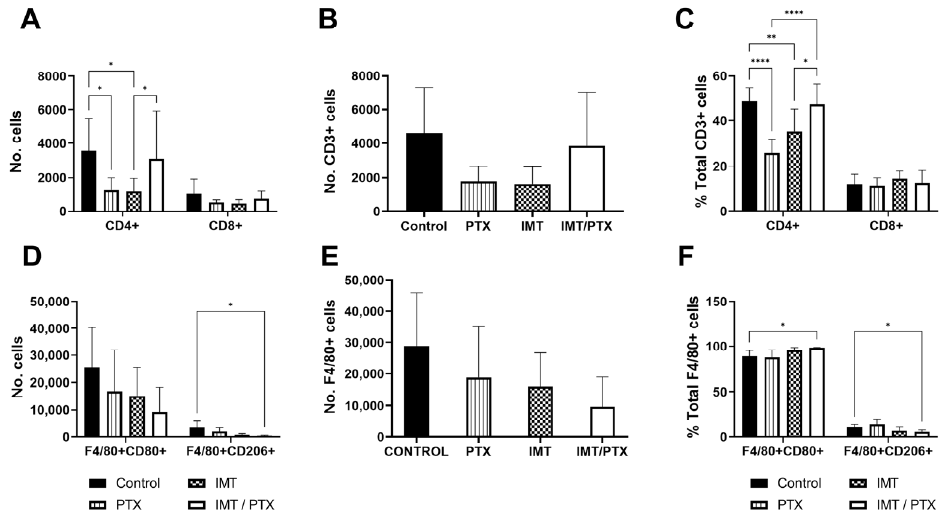
Figure 4. PTX is shown to recover loss of CD4+ T cell population and combination IMT/PTX significantly decreases the number of M2-phenotype macrophages. T-cell and macrophage panels were utilized with flow cytometry performed on E0771 tumors extracted on day 12 ( n = 4/group) to distinguish subpopulations of ( A – C ) T-cells and ( D – F ) macrophages. Additional data shown in Supplementary Materials. Mean ± SD (* indicates p < 0.05; ** indicates p < 0.01; **** indicates p < 0.0001; multiple t